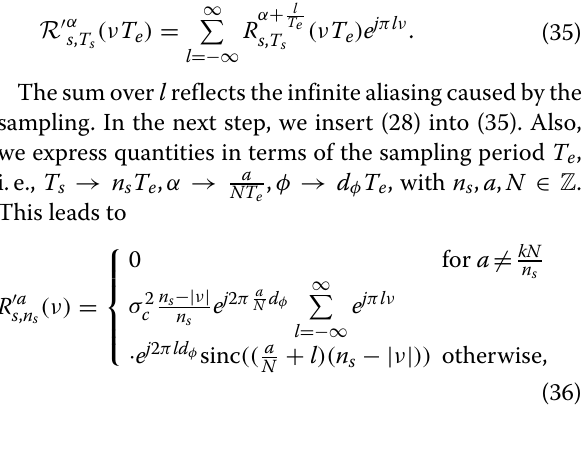
algorithms, Dice approximately possesses a desirable fea- ture called constant false alarm rate i. e., its test statistic is independent of system parameters like the receiver noise